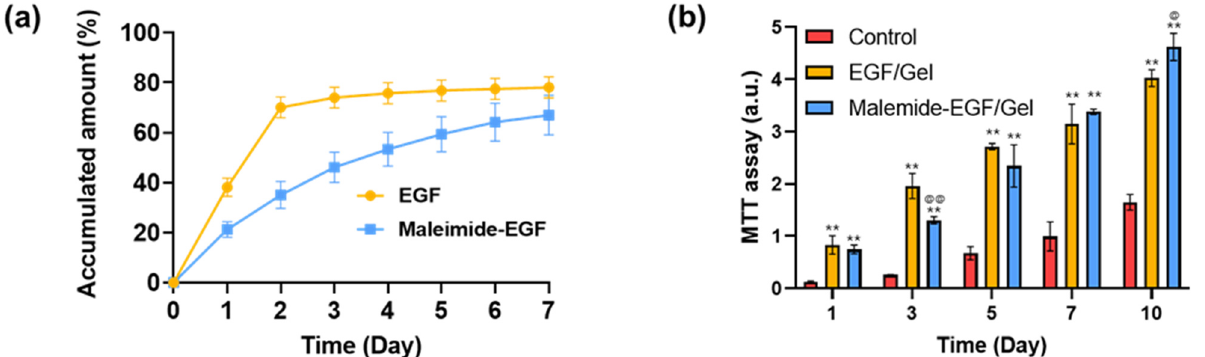
Figure 8. ( a ) Release profiles of EGF and maleimide-EGF from furfuryl-gelatin hydrogels. ( b ) Cell proliferation by EGF and maleimide-EGF incorporated in furfuryl-gelatin hydrogels. The symbols * and @ are used to represent significant differences when compared with the control and EGF/Gel groups, respectively. The significant differences are represented by 0.01 < p < 0.05 (* and @) and p < 0.01 (** and @@).